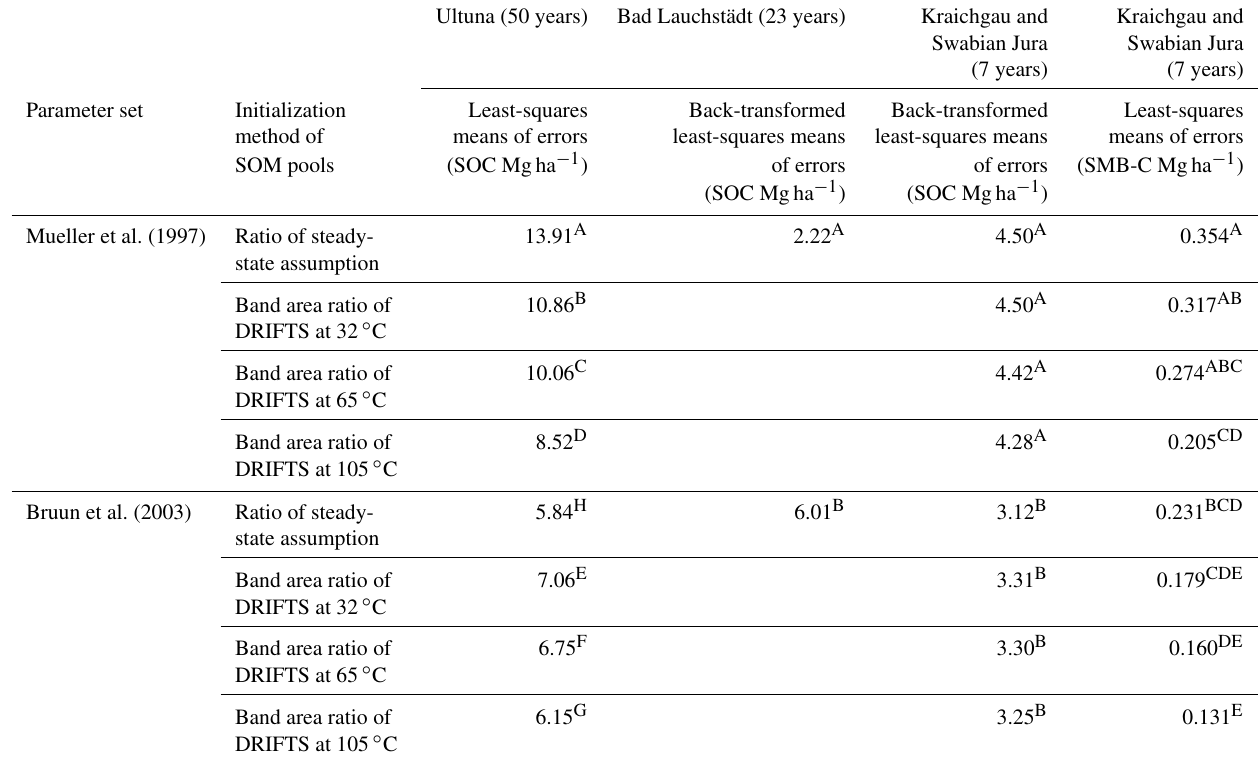
Table 4. Effect of the initialization method on simulation errors. Displayed are estimated least-squares means of the absolute error of Daisy bare fallow simulations of SOC and SMB-C for the sites of Ultuna, Bad Lauchstädt, and Kraichgau and Swabian Jura combined. Means are the estimate for the end of the simulation period (number of years in brackets). Different capital letters indicate significant differences ( p< 0 . 05) within columns (not tested between sites). For Bad Lauchstädt, the initialization effect was nonsignificant, so only the least-squares means for the effect of the parameter set are